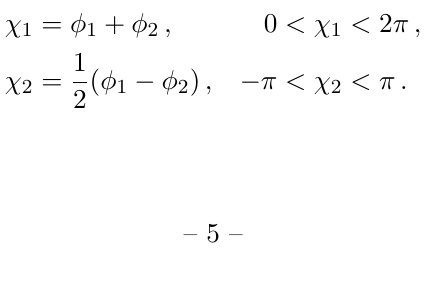
Figure 1 . The angles given in eq. (2.9), where ˆ n Λ where f are made of the amplitudes related to Λ i and α . The explicit forms are given in table 1, where we have used the Legendre polynomial Λ of P = (3 cos 2 θ − 1) / 2 for the later convenience. In general, D ( ~ Ω) can be applied 2 2